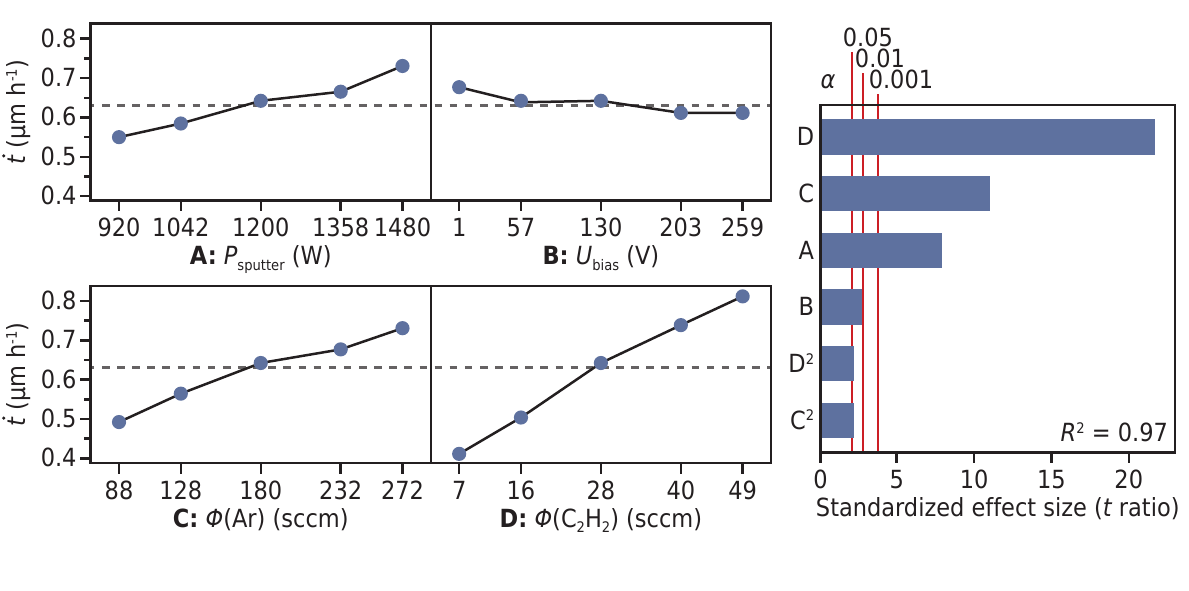
Figure 6. Main effect plot and Pareto chart of standardized effects showing the relationship between the varied deposition parameters and the deposition